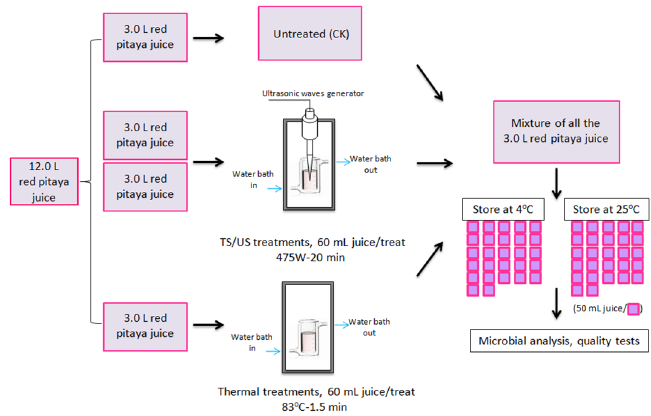
Figure 1. A schema of the experimental design for each batch.